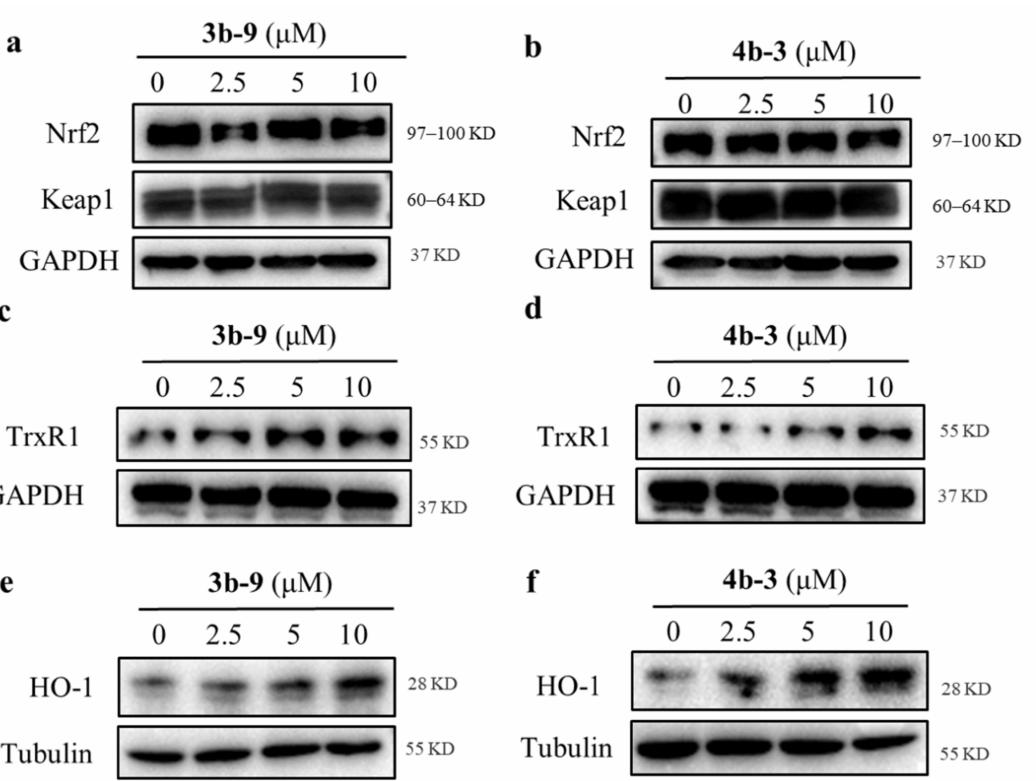
Figure 5. The effect of 3b-9 and 4b-3 on the expression of Nrf2, Keap1, TrxR1 and HO-1. ( a ) HaCaT cells were treated with 3b-9 (2.5–10 µ M) for 24 h. The expression of Nrf2 and Keap1 was detected by Western blotting assay. ( b ) HaCaT cells were treated with 4b-3 (2.5–10 µ M) for 24 h. The expression of Nrf2 and Keap1 was detected by Western blotting assay. ( c ) HaCaT cells were treated with 3b-9 (2.5–10 µ M) for 24 h. The expression of TrxR1 was detected by Western blotting assay. ( d ) HaCaT cells were treated with 4b-3 (2.5–10 µ M) for 24 h. The expression of TrxR1 was detected by Western blotting assay. ( e ) HaCaT cells were treated with 3b-9 (2.5–10 µ M) for 24 h. The expression of HO-1 was detected by Western blotting assay. ( f ) HaCaT cells were treated with 4b-3 (2.5–10 µ M) for 24 h. The expression of HO-1 was detected by Western blotting assay. All the original images for the Western blotting assay are provided in Supplementary Figures